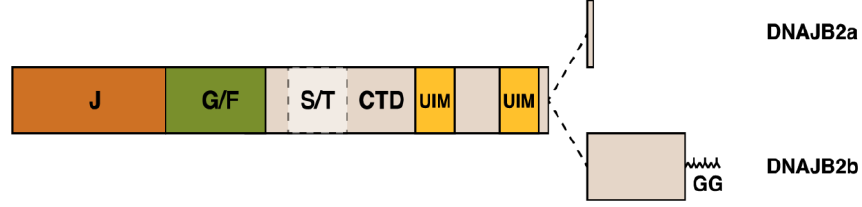
Figure 5. Schematic structure of the DNAJB2 protein and the alternatively spliced C-terminal parts of the two isoforms. The J, G/F, and C-terminal (CTD) domains, the Ser/Thr-rich region, two ubiquitin-interacting motifs (UIM) and the C-terminal geranylgeranyl (GG) anchor of DNAJB2b are indicated.